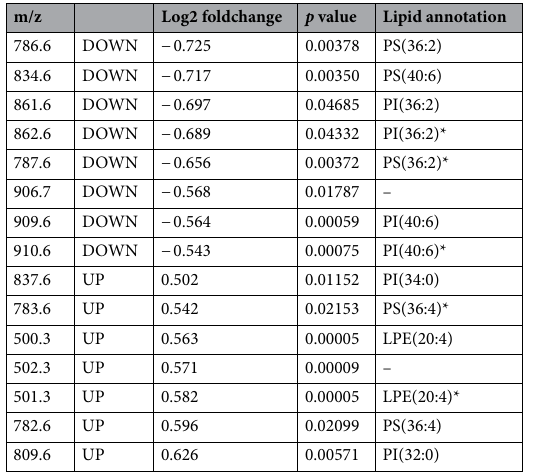
Table 2. More and less abundant lipids in PT_S3 cells. Asterix indicates the second lipid